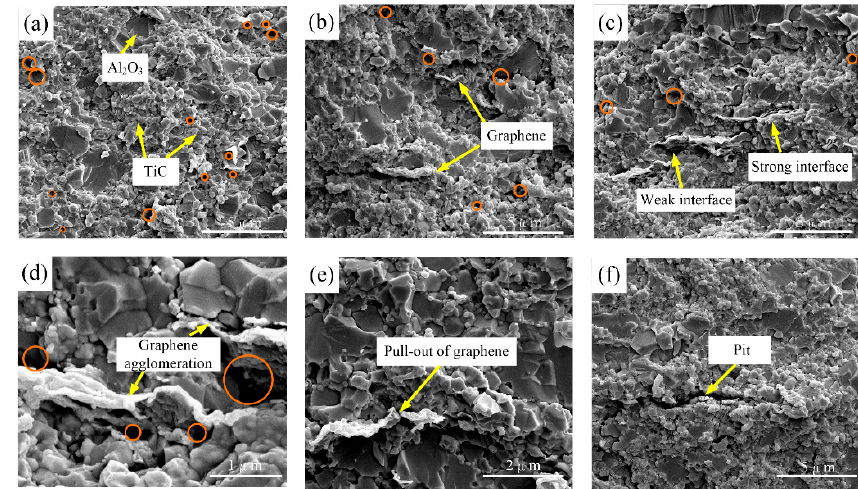
Figure 4. SEM morphologies of fracture surface of ( a ) composite A, ( b ) composite C, ( c ) composite E, ( d ) graphene agglomeration, ( e ) pull-out of graphene, and ( f ) pit left by graphene.